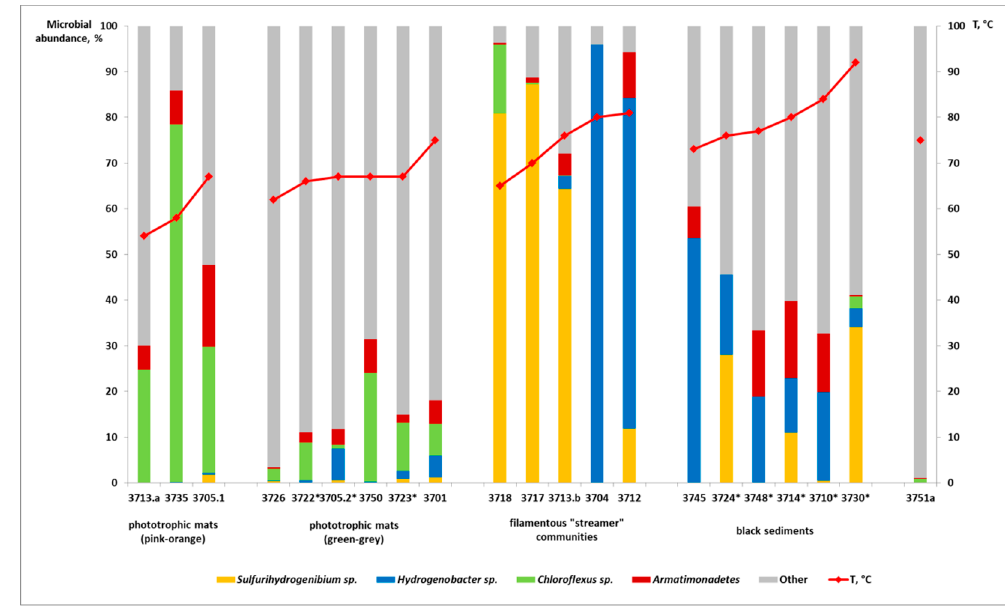
Figure 5. Comparison of the relative abundance of the most numerous taxonomical groups ( Sulfurihydrogenibium spp., Hydrogenobacter spp., Chloroflexus spp., and Armatimonadetes representatives) in five major CHS habitat types.